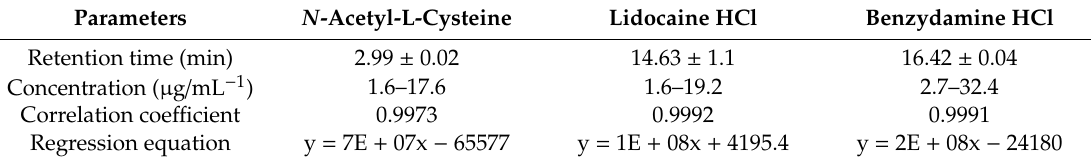
Figure 7. Separation and quantification N -acetyl-L-cysteine, lidocaine HCl, and benzydamine HCl by HPLC at 210 nm. The chromatogram representing the specificity of the developed method. Table 4. Results of assay validation parameters of HPLC for the determination of N -acetyl-L-cysteine,